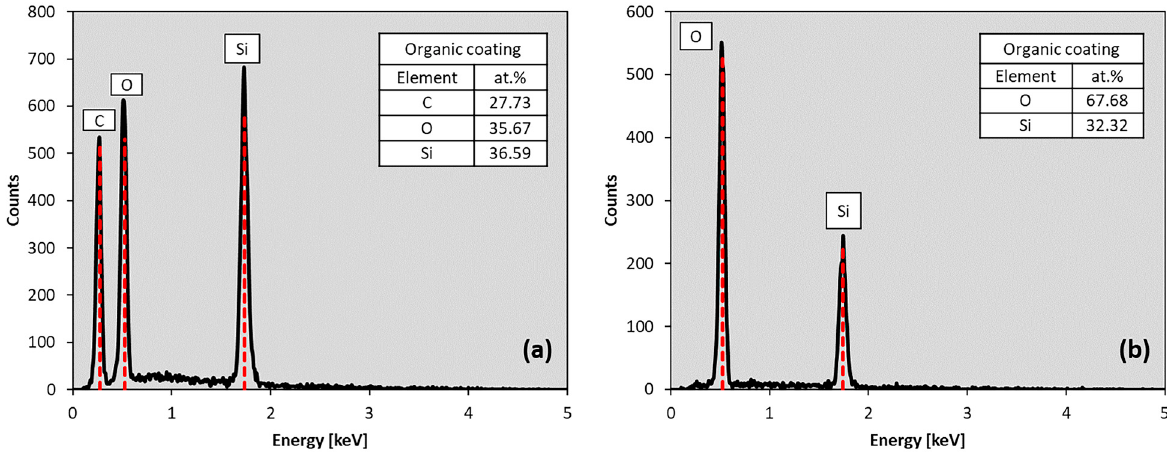
Figure 5. EDS results, ( a ) organic and ( b ) inorganic coating.